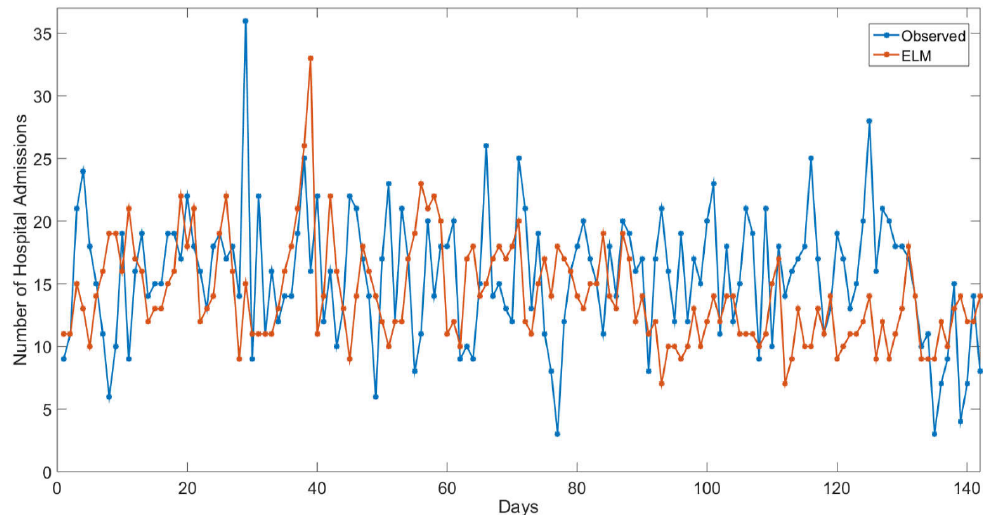
Figure 8. The number of hospital admissions by day of the test set for ELM lag 3-Campinas (observed versus estimated values).